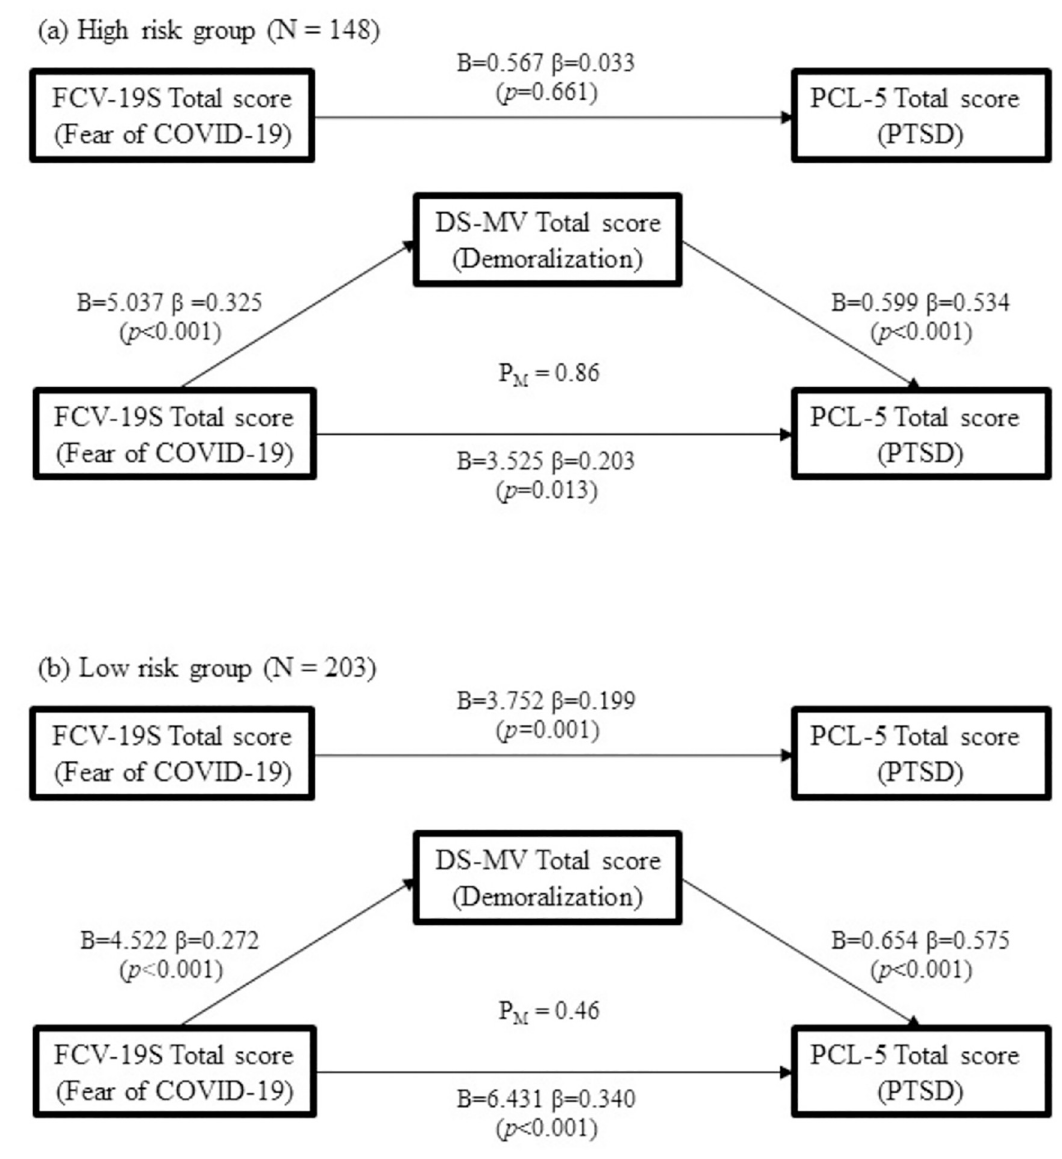
Fig 2. Mediation model of the effects of demoralization on the relationship between fear and PTSD in both (A) high-risk group (N = 148) (Sobel’s test: Z = 3.64, p < 0.001) and (B) low risk group (N = 203) (Sobel’s test: Z = 3.72, p < 0.001). (FCV-19S = The Fear of COVID-19 Scale; DS-MV = Demoralization Scale—Mandarin Version; PCL-5 = Posttraumatic Stress Disorder Checklist for DSM-5; P M = the ratio of the indirect effect to the total